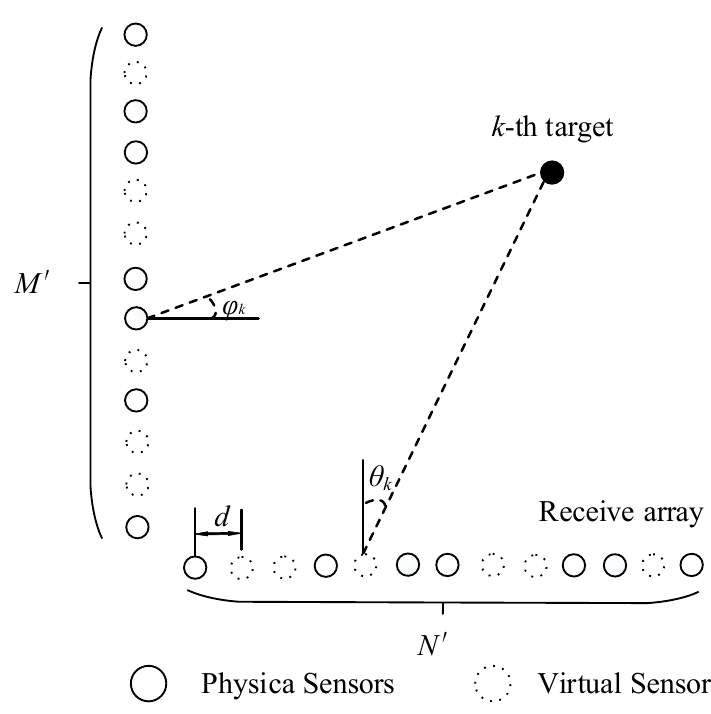
Figure 2. Sensor distribution of bistatic coprime array MIMO radar after interpolating virtual sensors.